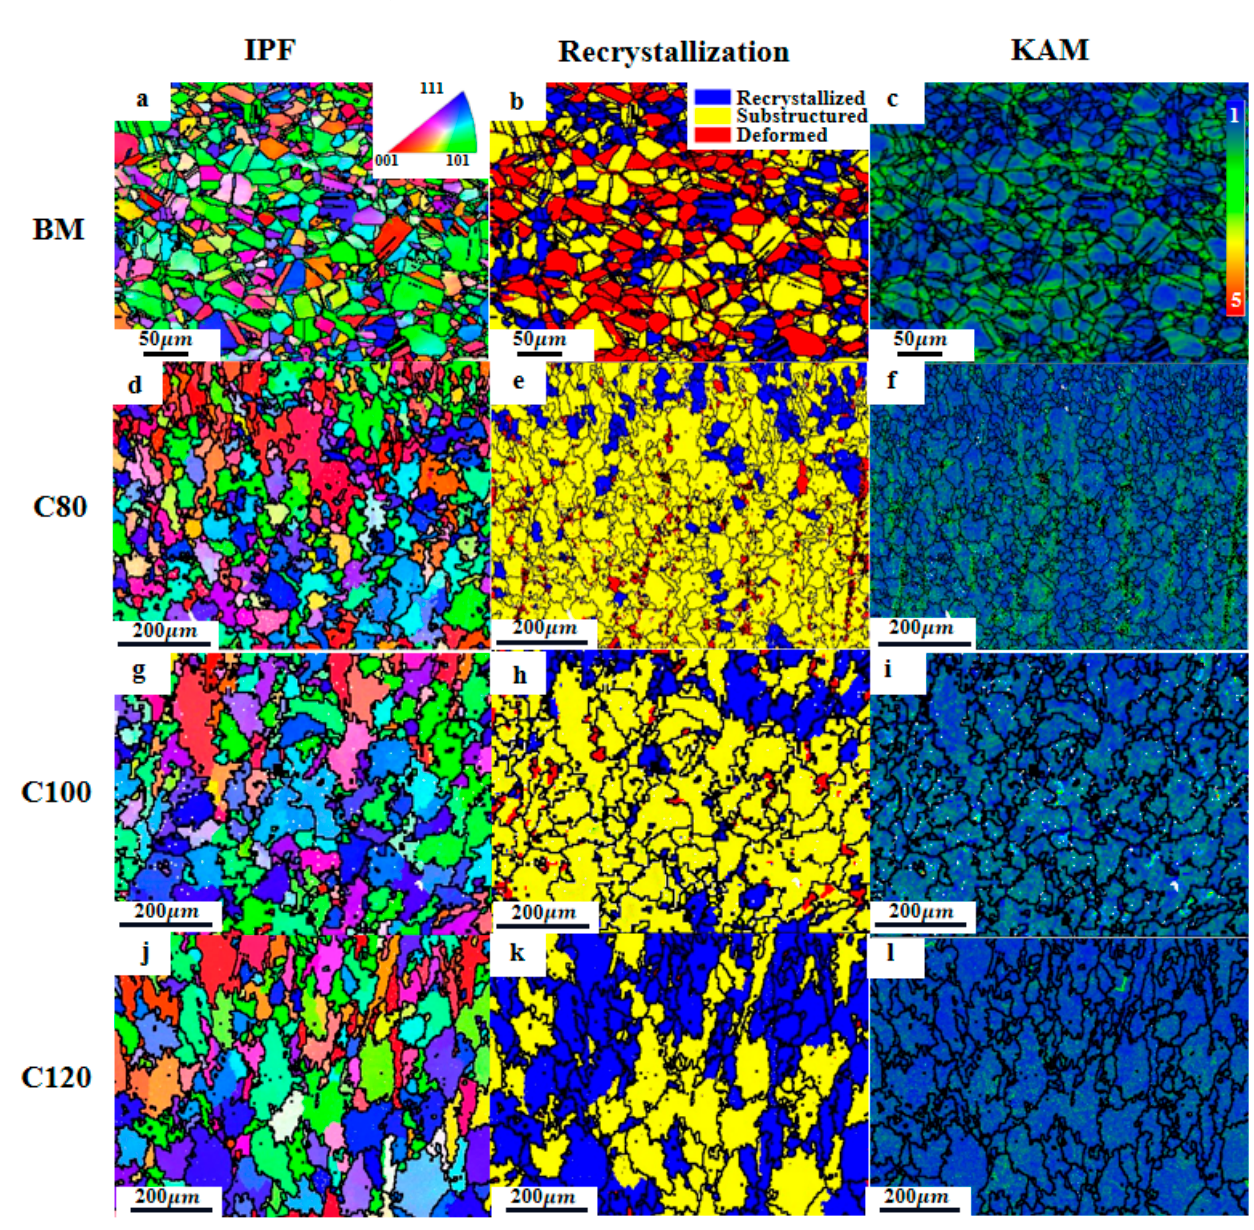
Figure 4. IPF, recrystallization, and KAM of Inconel 625 under EBSA treatment at different scanning speeds: BM ( a – c ); C80 ( d – f ); C100 ( g – i ); C120 ( j – l ).